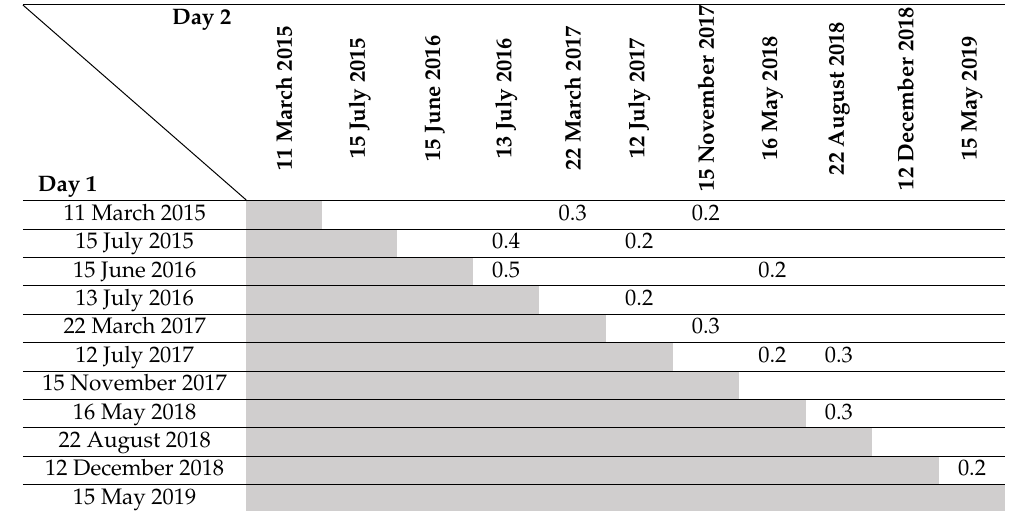
Figure 8. ALOS-1 interferometric coherence. Tables 4 and 5 contain information about the coherence of PALSAR-2 interferometric pairs from tracks 127 and 128. In Figure 9, the interferometric coherence values for 19 PALSAR-2 image pairs over the landslide territory acquired from all two tracks are presented. The largest coherence is typical for the image pairs acquired during cold seasons (diamonds). Table 4. ALOS-2 coherences, track 127.